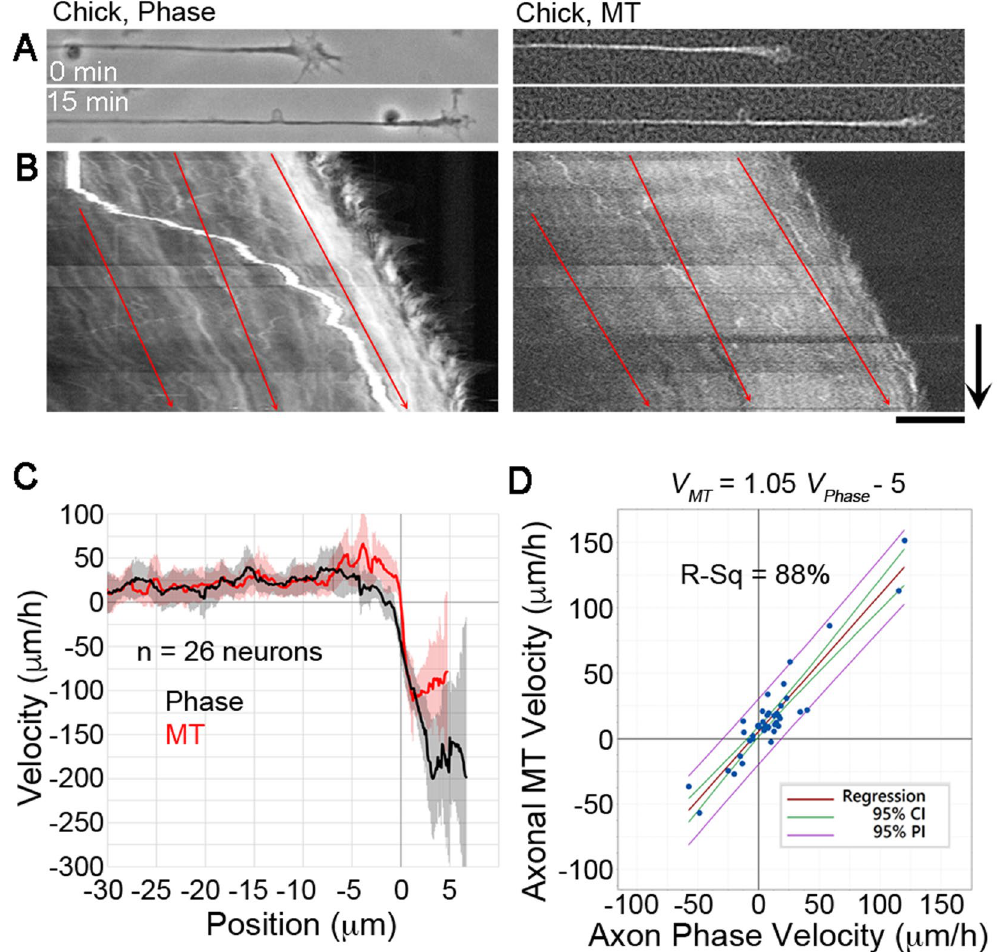
Figure 2. Phase-dense material and MTs move anterogradely during axonal elongation. ( A ) Phase contrast and MT FSM still images of a chick DRG neurite at the beginning and end of a time-lapse sequence. ( B ) Phase and MT kymographs showing anterograde flow; arrow = 5 min, bar = 10 μ m. The red arrows are guides to illustrate motion. ( C ) Velocity ± 95% CI of phase-dense objects and MTs in 26 neurons. ( D ) Regression analysis of the motion of phase-dense objects and